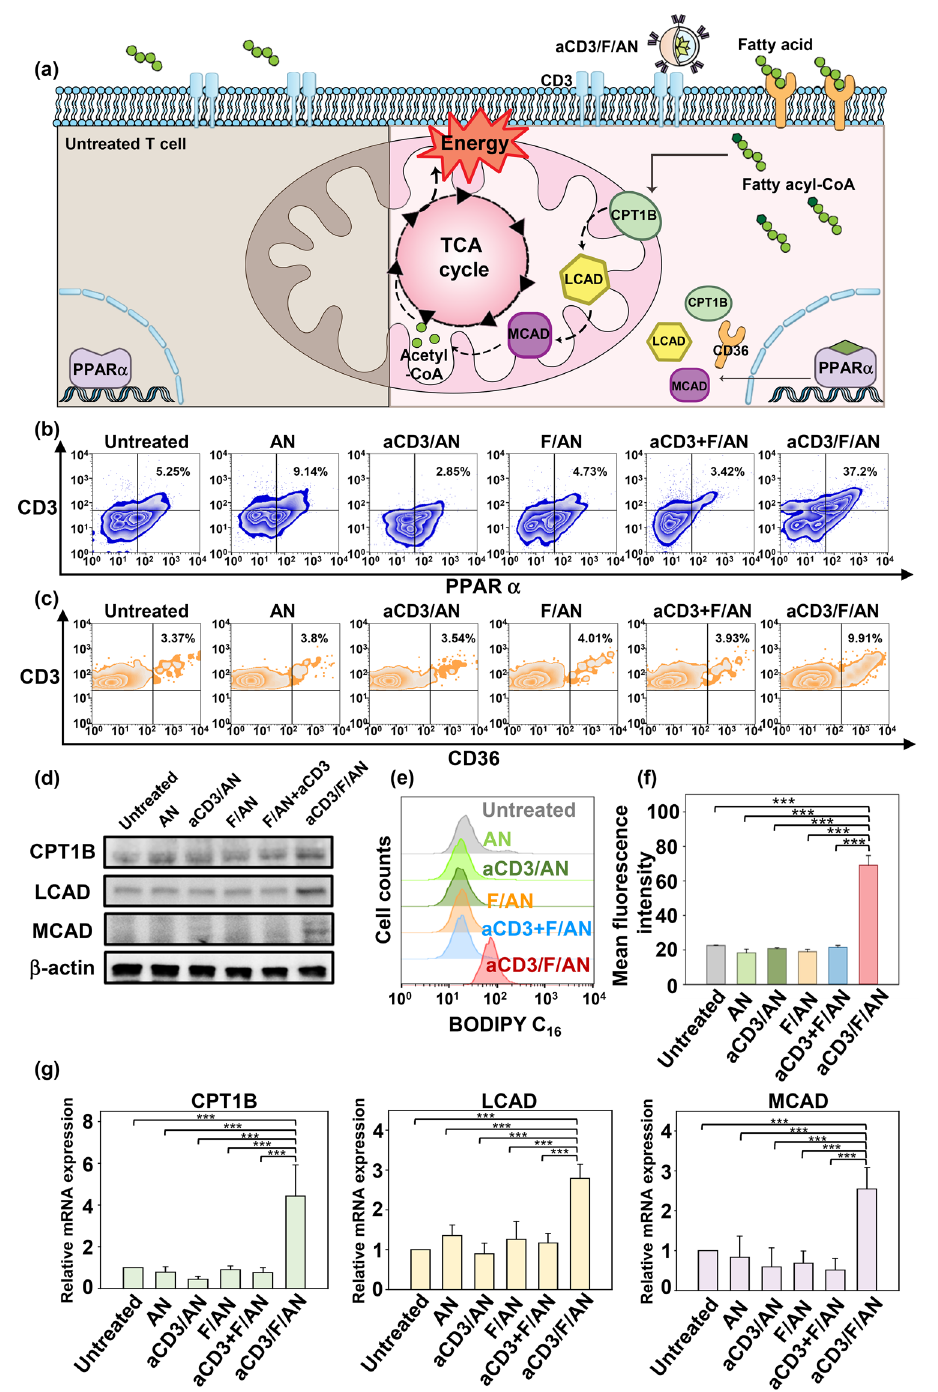
Fig. 4 Fatty acid metabolism‑associated gene expression and lipid uptake in T cells. a The cellular mechanism underlying aCD3/F/AN‑induced enhancement of lipid metabolism is illustrated. The left half of the schematic cell depicts the untreated condition, and the right half shows treatment with aCD3/F/ANs. aCD3/F/AN treat‑ ment is proposed to activate PPARα in T cells, leading to over‑expression of fatty acid metabolism‑associated proteins, including CD36 (fatty acid translocase), CPT1B, LCAD and MCAD. The increased fatty acid metabolism in mitochondria generates higher energy via the TCA cycle. b The corresponding levels of PPARα protein in T cells (PPARα + /CD3 + ), measured by flow cytometry. c The levels of CD36 protein in T cells (CD36 + /CD3 + ), measured by flow cytometry. d Protein expression levels of CPT1B, LCAD and MCAD in T cells were measured by western blot. e, f T cells treated with different nanoparticle preparations were incubated with fluo‑ rescent lipid BODIPY C 16 , and the association of fluorescent lipid with T cells was determined by flow cytometry ( e ) and expressed as mean fluorescence intensity ( f ) (***P < 0.001). g mRNA expression levels of the fatty acid metabolism‑associated genes, CPT1B, LCAD and MCAD, determined by RT‑PCR (***P <